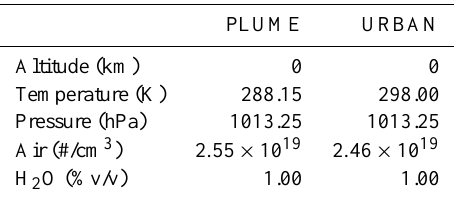
Table 1. Meteorological parameters for scenarios as defined by Poppe et al. (2001).